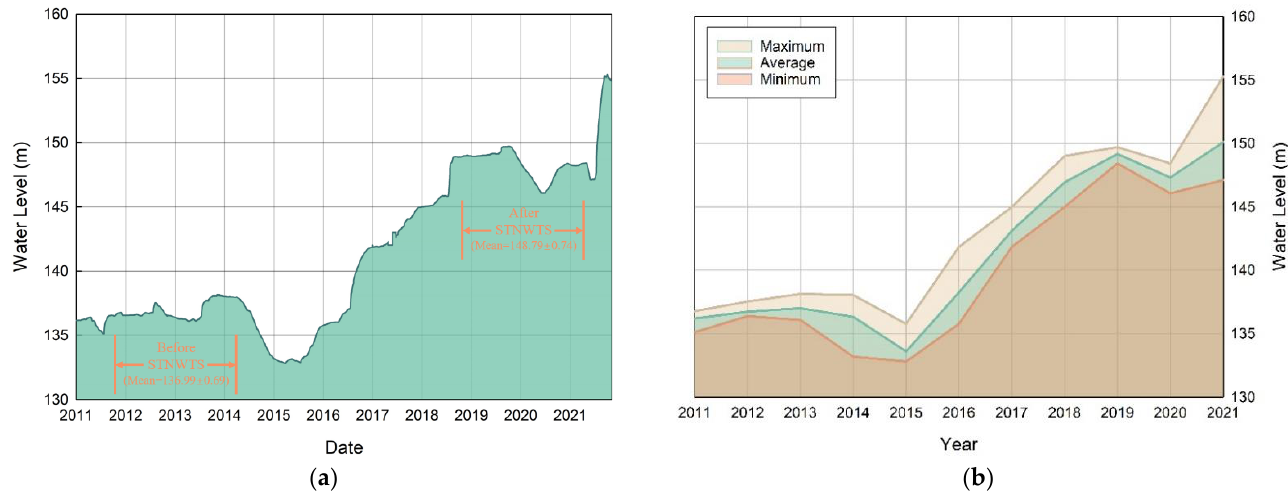
Figure 1. ( a ) Daily water level of the Miyun Reservoir from 2011 to 2021. The orange color marks the two study periods of this study, with the mean water level and standard deviation during the two periods. ( b ) The annual minimum, maximum and average water level of the Miyun Reservoir from 2011 to 2021. Data were obtained from Beijing Water Authority official website